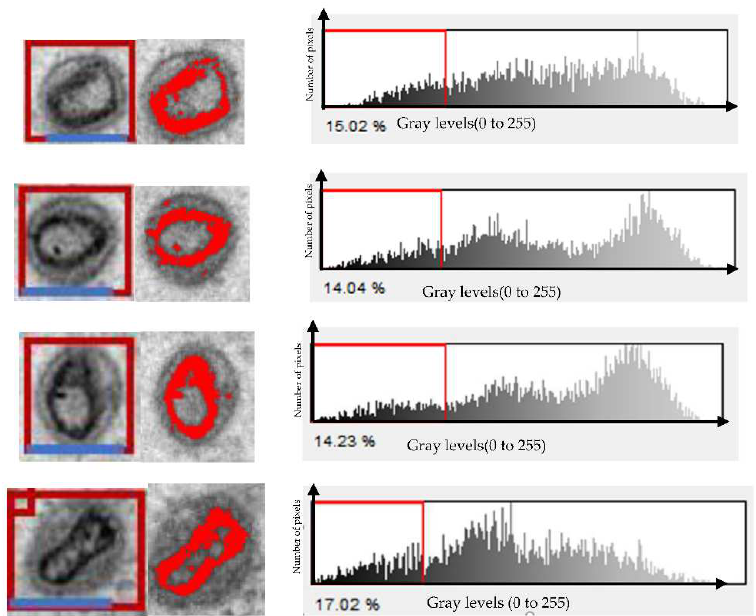
Figure 3. The first column represents 4 single microphages after uptake of the SPIO nanoparticles. The blue scale bar on the first column of the images represents 100 nm. The second column represents the segmented regions in red color where the SPIOs NPs inside the lysosomes or microvesicles. The third column is the histogram of the image. The red line represents the threshold chosen at the first minimum. The vertical axis represents the number of pixels for each gray level. The horizontal axis represents gray levels (0 to 255).